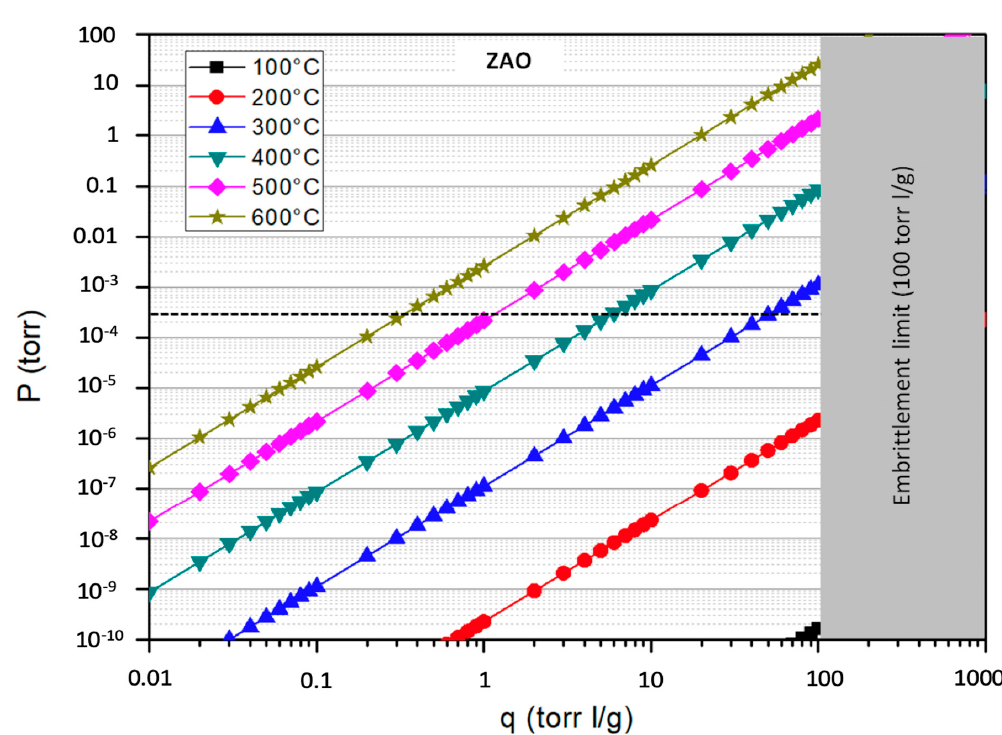
Figure 6. Sieverts’ plot of the ZAO alloy.